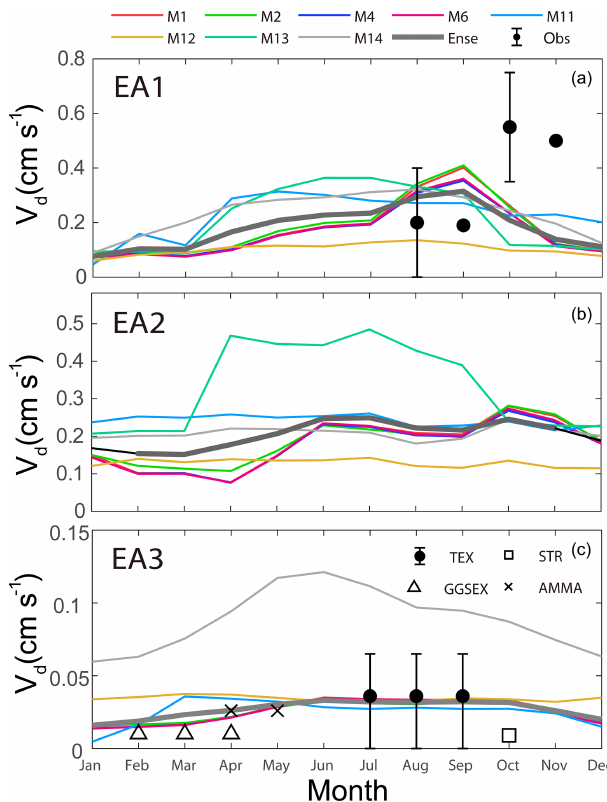
Figure 9. Simulated and observed monthly O 3 dry deposition ve- locities ( V d ) for M1, M2, M4, M6, M11, M12, M13 and M14 for three subregions of East Asia: EA1 (a) , EA3 (b) and EA3 (c) . TEX, STR, GGSEX and AMMA denote observations for TexAQS06 (7 July–12 September 2006; northwestern Gulf of Mexico), STRA- TUS06 (9–27 October 2006; the persistent stratus cloud region off the coast of Chile in the eastern Pacific Ocean), GasEx08 (29 February–11 April 2008; the Southern Ocean), and AMMA08 (27 April–18 May 2008; the southern and northern Atlantic Ocean). Ob- servational data were taken from Sorimachi et al. (2003), Pan et al. (2010) and Helmig et al.